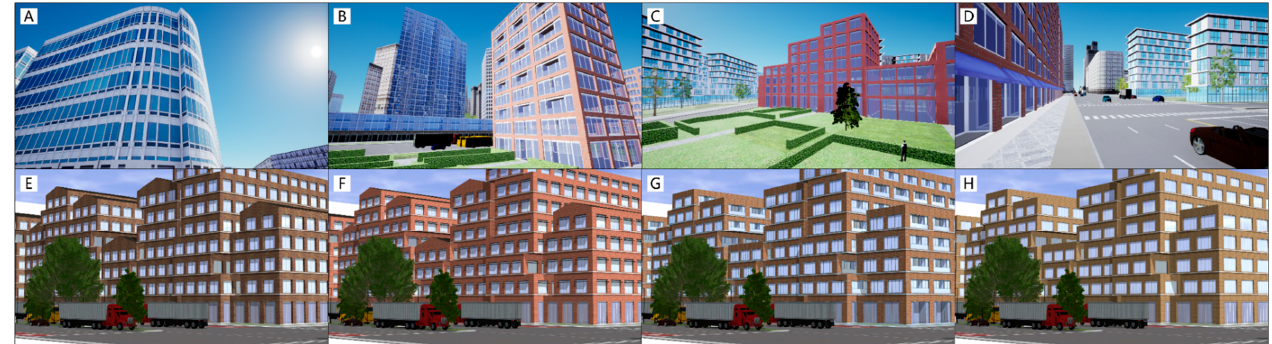
Figure 12. Different facade textures applied to the buildings (( A , B ) showing textures for offices, ( C ) showing textures for schools, ( D ) showing textures for retail space, ( E – H ) showing different visual effects when applied certain textures in the same building, ( E ) applying double slope roofs and brown bricks on walls, ( F ) applying double slope roofs and brownish red ceramic plate curtain wall, ( G ) applying flat roofs and brown ceramic tiles on walls, ( H ) applying flat roofs and khaki bricks on walls).